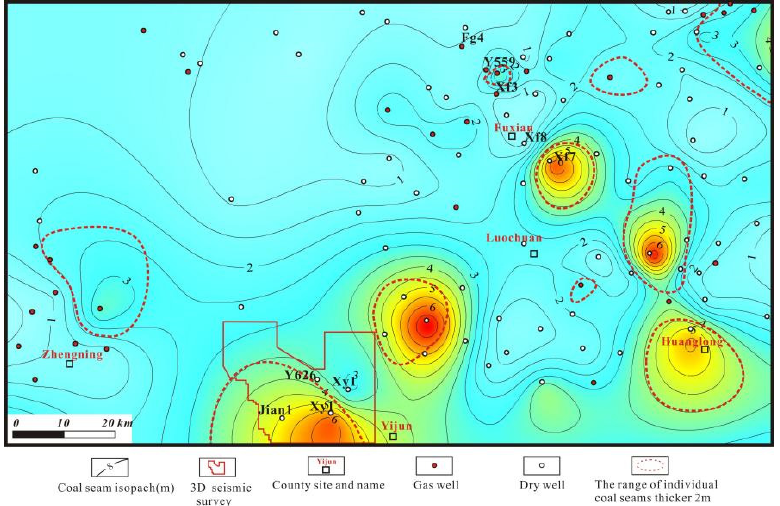
Figure 8. Coal seam isopach map of the Taiyuan Fm. on the southeastern margin of the Ordos Basin. A comparison of the coal seam thickness maps of the Taiyuan and Shanxi Fms. reveals that from the Taiyuan to Shanxi Fms., the thicker coal seams are located northward. The thickness basically exists for both the Taiyuan and Shanxi Fms. (Figure 9).